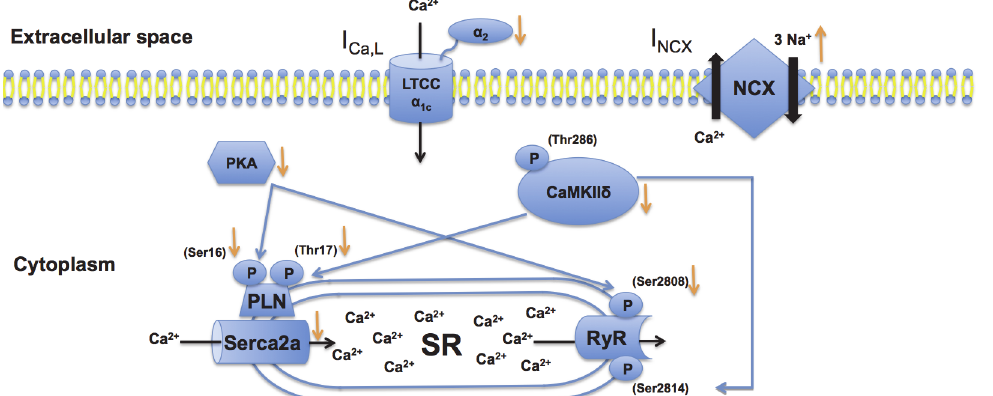
Fig 6. Remodeling of Ca 2+ handling proteins during atrial fibrillation and heart failure. Changes in protein expression are indicated by arrows (orange color). Solid black arrows indicate transport directions of Ca 2+ or Na + ions, respectively. Decreased levels of Ca 2+ -calmodulin-dependent protein kinase (CaMK) II δ and protein kinase A (PKA) causes hypophosphorylation of phospholamban (PLN) and ryanodine receptor (RyR) 2, leading to reduced Ca 2+ uptake into the sarcoplasmic reticulum through sarcoplasmic reticulum Ca 2+ -ATPase (Serca) 2a. Increased intracellular Ca 2+ levels and upregulation of Na + - Ca 2+ exchanger (NCX) 1 expression enhance electrogenic Na + -Ca 2+ exchange. This mechanism is attenuated by reduced L-type calcium channel (LTCC) expression that limits systolic Ca 2+